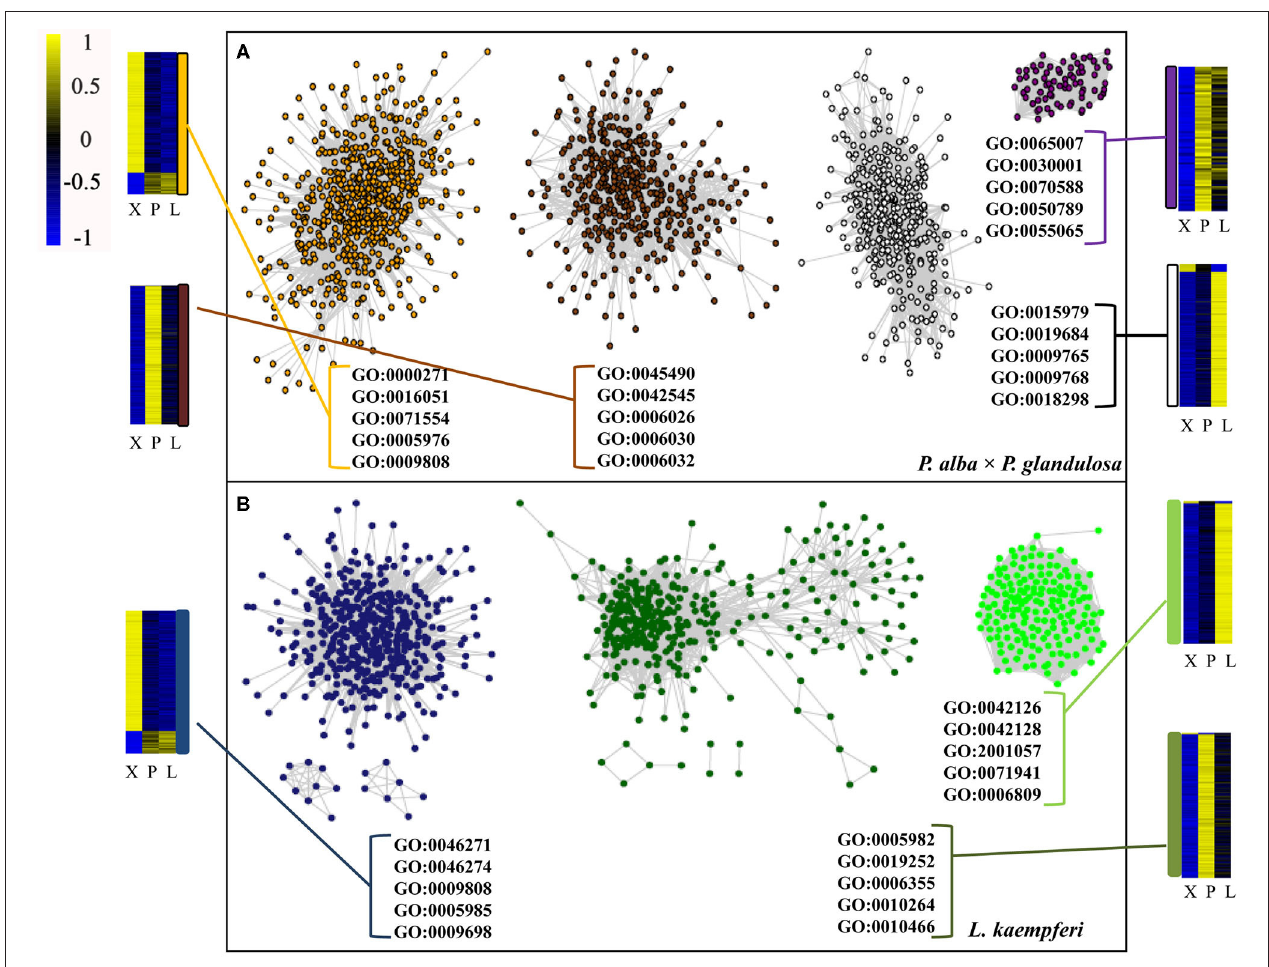
FIGURE 5 | Co-expression network and GO analysis for each module in the two tree species. (A) Co-expression network in P. alba × P. glandulosa . (B) Co-expression network in L. kaempferi . In these networks, only the top 50 000 gene co-expression pairs are displayed. Only the top five GO terms under the biological process category appear in each module. The heatmaps are for gene expression levels in the different